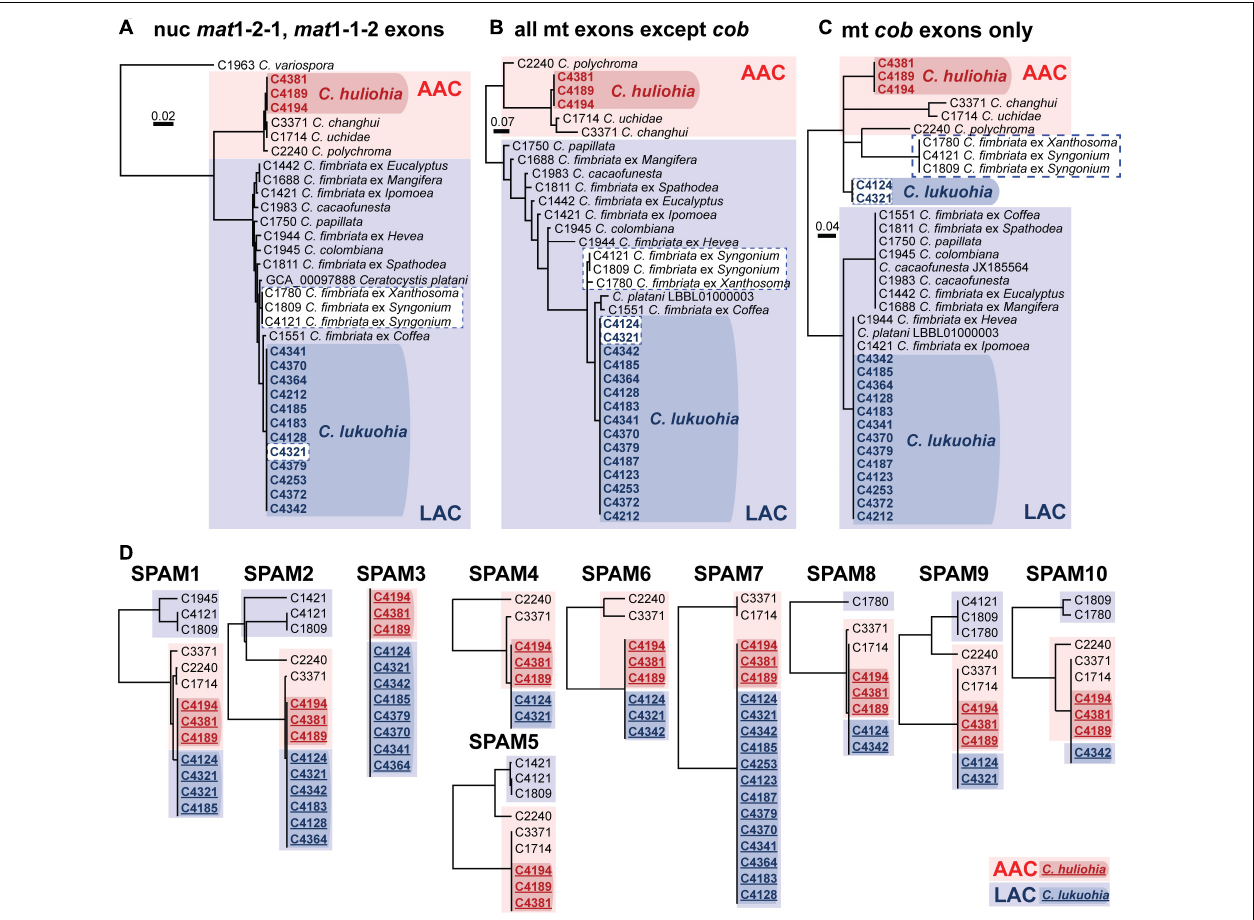
FIGURE 3 | (A–C) Bayesian inference trees of exons of nuclear and mitochondrial genes of Latin American Clade (LAC) and Asian Australian Clade (AAC) species of Ceratocystis . (A) Nuclear genes ( mat1-2-1 and mat1-1-2 exons). (B) All mitochondrial exons besides cob . (C) Exons of cob . (D) Separate UPGMA distance trees for each SPAM element. Members of the Asian-Australian Clade are in red, and those of the Latin American Clade are in blue. The SPAM9-positive LAC taxa are highlighted in white boxes with dashed blue borders in panel (A–C) , highlighting their aberrant phylogenetic placement due to co-conversion of cob by SPAM9. In D, sequences from C. lukuohia (bold blue, underlined, in dark blue box) and C. huliohia (bold red, underlined, in dark red box) are identical and group with other AAC species (plain text, in light red boxes) and apart from LAC sequences (plain text, in light blue boxes). Sequences of SPAM5 were not available for C. lukuohia